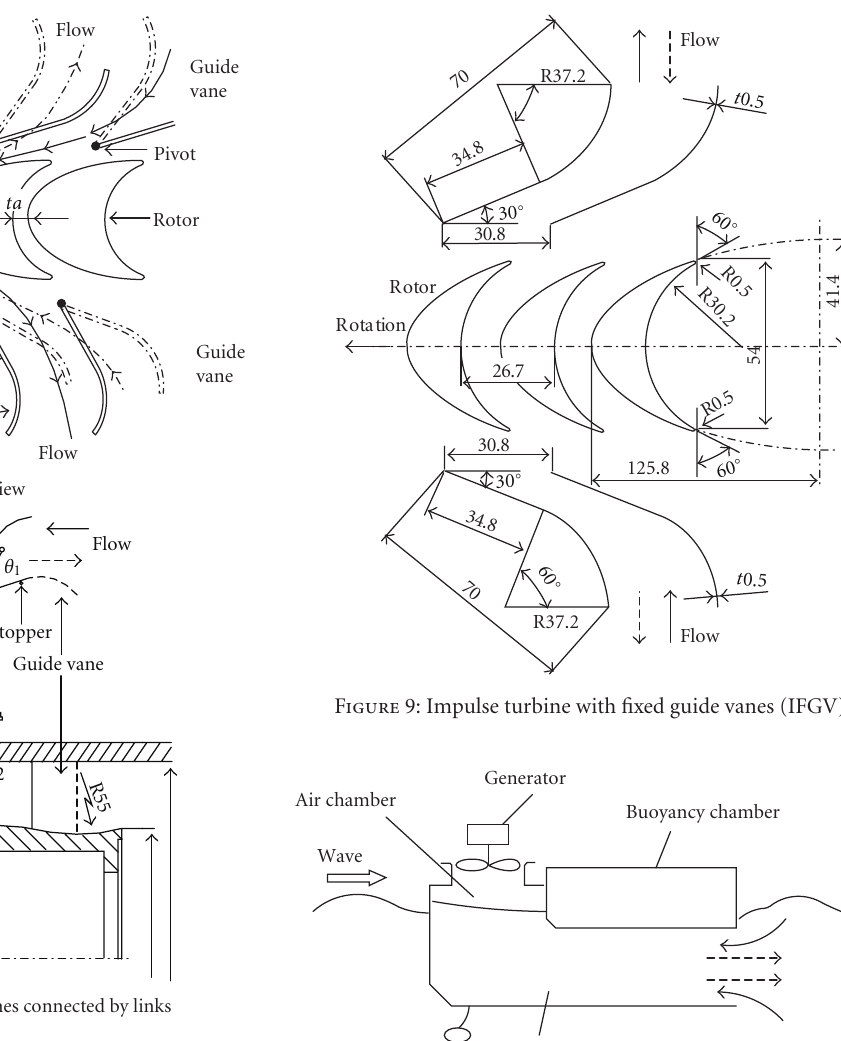
Figure 8: Impulse turbine with self-pitch-controlled guide vanes (ISGV).